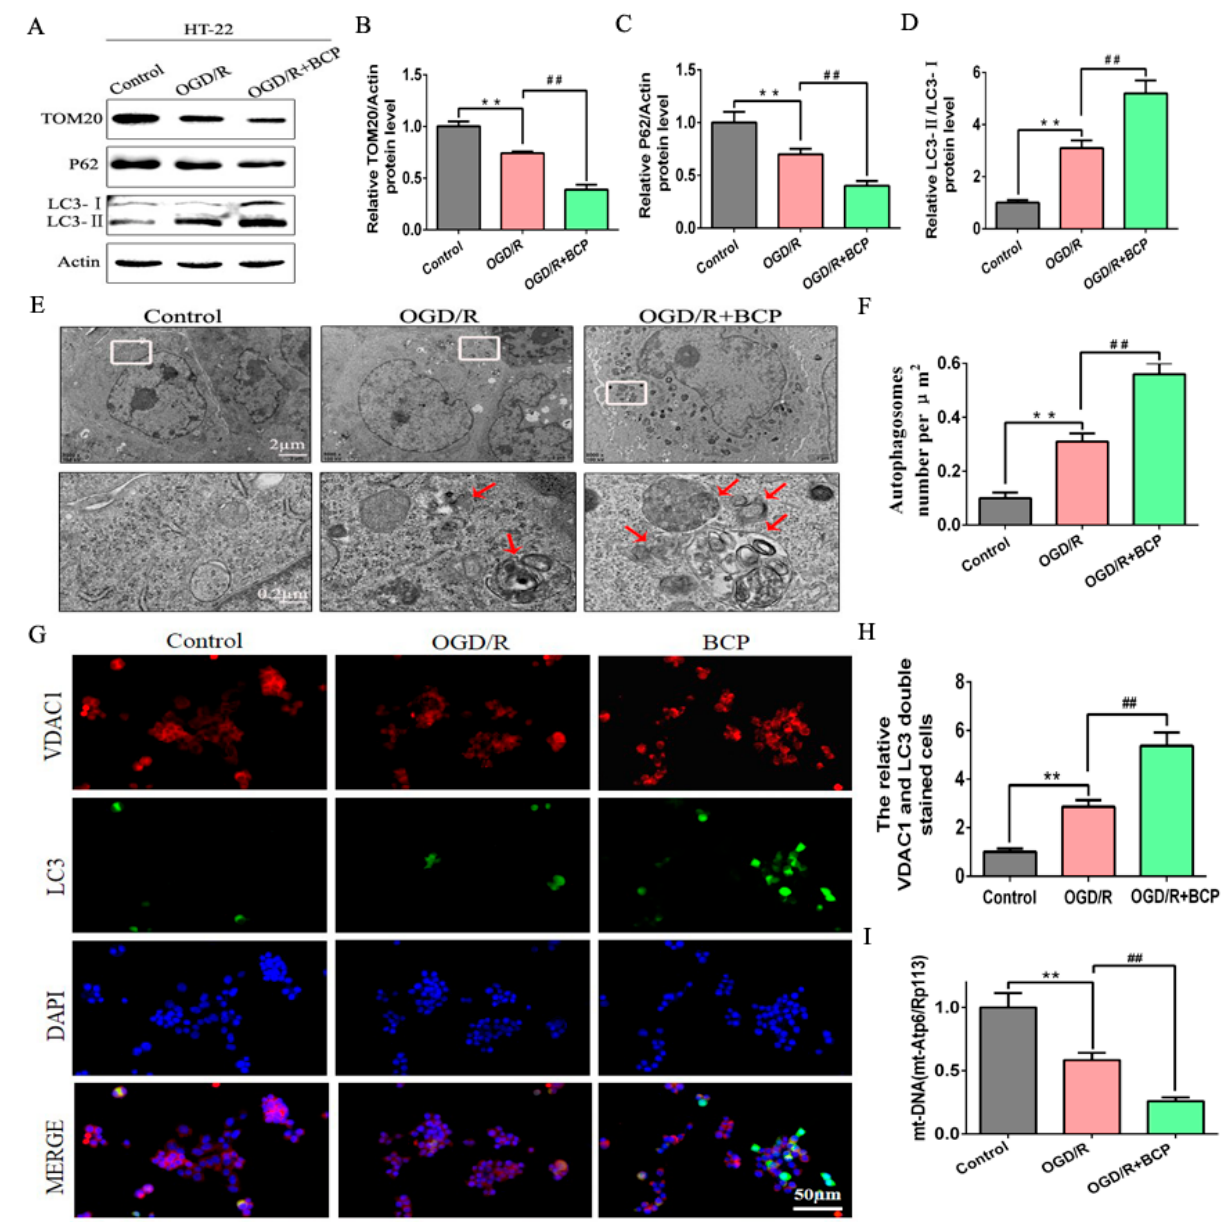
Figure 3. BCP enhanced mitophagy in OGD/R-injured HT-22 cells. ( A – D ) Representative Western blots showing protein levels of p62 and TOM20, and the protein ratio of LC3-II/LC3-I. p62 and TOM20 protein levels were normalized to β -actin. ( E , F ) Transmission electron microscopy revealed that BCP pretreatment increased numbers of autophagosomes in HT-22 cells after OGD/R. Red arrows indicate autophagosomes. ( G , H ) Double-immunofluorescence staining for LC3B and VDAC1 in HT-22 cells at 24 h after reperfusion, VDAC1 (red) and LC3B (green) double-stained cells (yellow) indicate mitophagy (scale bar = 50 µ m, 400 × magnification). ( I ) Relative mitochondrial DNA levels indicated by the ratio of mt-Atp6 were assessed by qRT-PCR. ( n = 3; ** p < 0.01 OGD/R group vs. control group; ## p < 0.01 OGD/R + BCP group vs. OGD/R